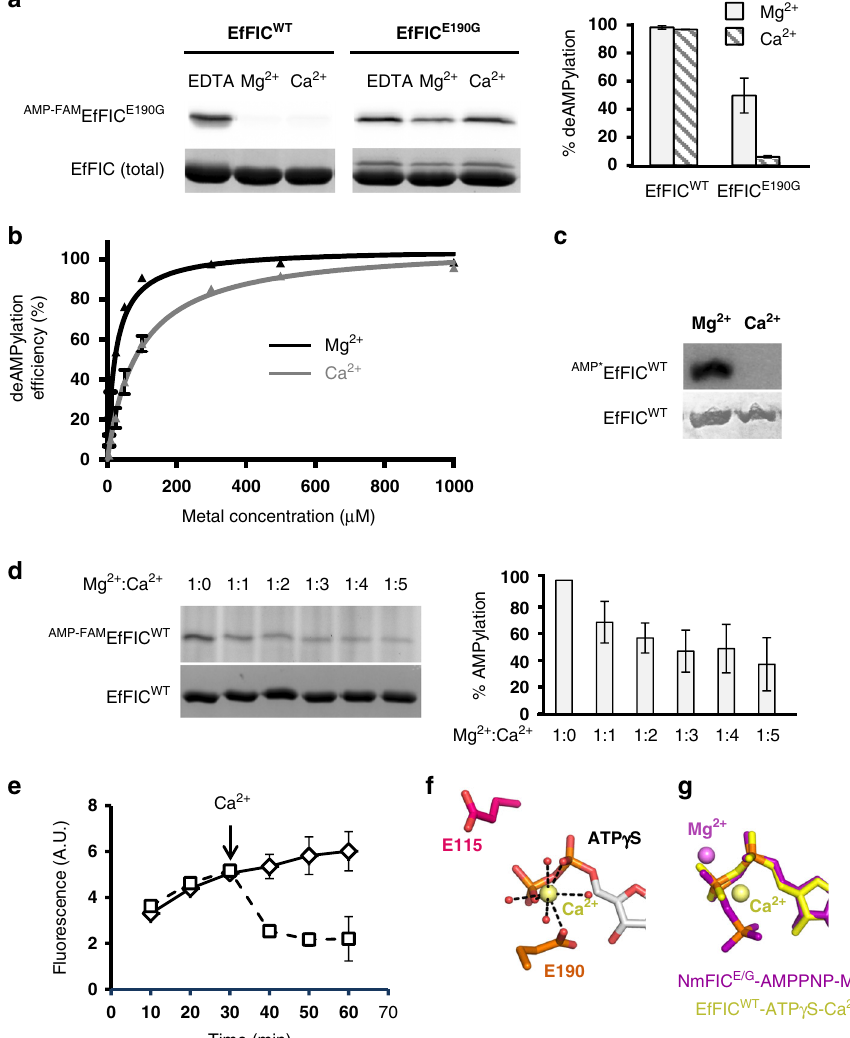
Fig. 3 The Mg 2 + /Ca 2 + ratio controls the balance between AMPylation and deAMPylation. a The conserved glutamate of FIC protein from Enterococcus faecalis (EfFIC) is required for deAMPylation in the presence of Mg 2 + and Ca 2 + . AMP-FAM EfFIC E190G was incubated with 6 µ M EfFIC WT and either 0.5 mM EDTA or 3 mM Mg 2 + or Ca 2 + . DeAMPylation was quanti fi ed by fl uorescence (right panel). b Determination of the apparent dissociation constants of Ca 2 + and Mg 2 + for EfFIC WT . EfFIC WT (4 µ M) was incubated with 5 µ M ATP-FAM, then deAMPylation was carried out in the presence of increasing metal concentrations. K D are 25 µ M ( R 2 = 0.98) for Mg 2 + and 90 µ M ( R 2 = 0.99) for Ca 2 + . c Ca 2 + inhibits EfFIC WT autoAMPylation. AMPylation was carried out for 1 h at 1 mM Ca 2 + or Mg 2 + using radiolabeled ATP and measured by autoradiography. d The net AMPylation ef fi ciency of EfFIC WT is controlled by the Mg 2 + /Ca 2 + ratio. EfFIC WT was incubated for 1 h with ATP-FAM at fi xed Mg 2 + concentration (1 mM) and increasing Ca 2 + concentrations. The steady- state AMPylation ef fi ciency was quanti fi ed by fl uorescence and expressed as the percentage of the maximal AMPylation level obtained with Mg 2 + alone (right panel). All measurements have p values <0.05 with respect to the experiment containing Mg 2 + alone. The total amount of EfFIC WT is shown (Coomassie staining). e The EfFIC activity switch is controlled by Ca 2 + . EfFIC WT (8 µ M) was incubated with 1 mM Mg 2 + , then the reaction was started by addition of 10 µ M ATP-FAM. The level of ATP-FAM EfFIC WT was quanti fi ed at the indicated time points using fl uorescence. At t = 30 min, 5 mM Ca 2 + (squares) or buffer (diamonds) was added and the reactions were carried out for another 30 min. f Close-up view of Ca 2 + bound to EfFIC WT -ATP γ S. The pentagonal bipyramidal coordination sphere of Ca 2 + is indicated by dotted lines. Water molecules are in red. Note that only the ADP moiety of ATP γ S is visible in the electron density. g Ca 2 + bound to EfFIC WT -ATP γ S is shifted with respect to Mg 2 + bound to AMPylation-competent NmFIC E/G -AMPPNP (PDF 3ZLM). All measurements were done in duplicate except in e (triplicate). Error bars correspond to standard deviations. Source data are provided as